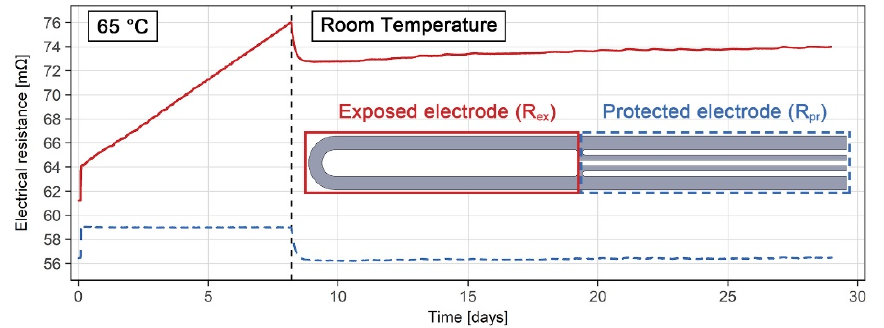
Figure 7. Electrical resistance results for the grade 316L ER sensor exposed to a 10% H 2 SO 4 solution with 5000 mg/L NaCl at 65 °C and room temperature.